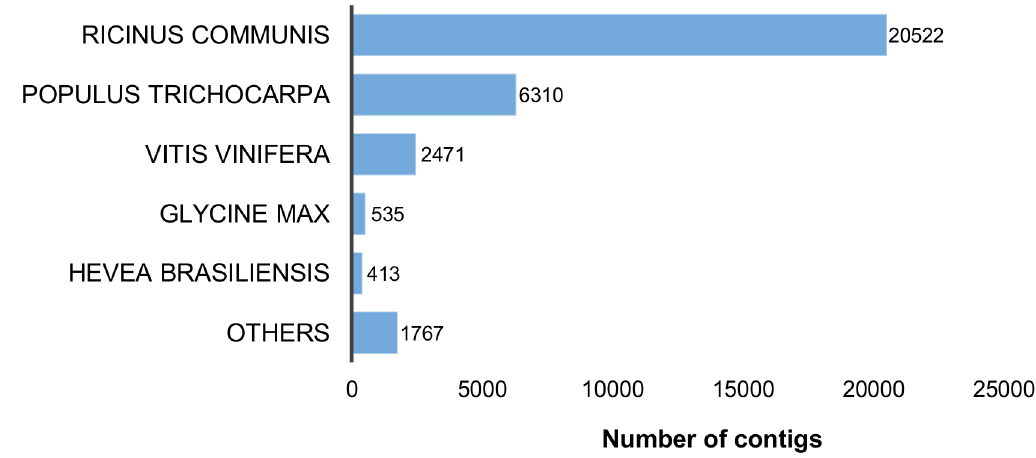
Figure 2. Top-hit species distribution in the BLASTx analysis against the nr database.